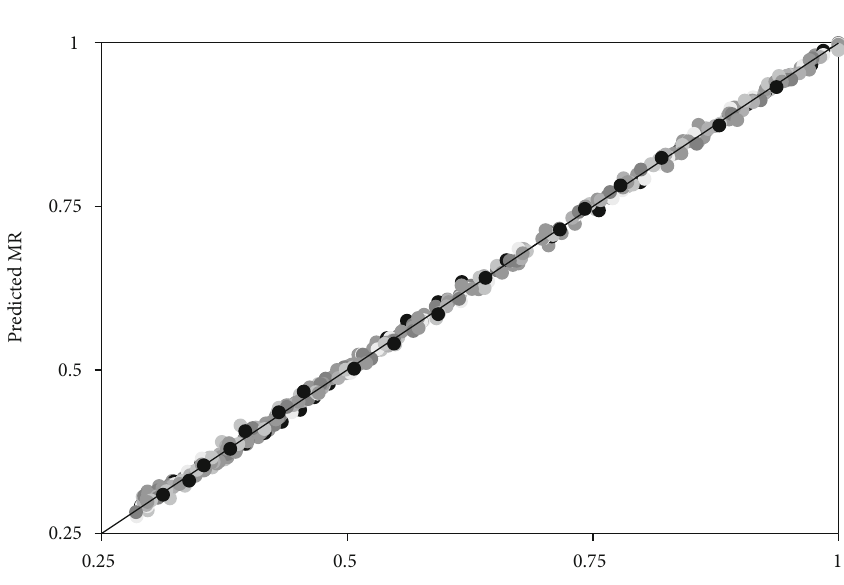
Figure 6: Comparison between the MR predicted by the two-term model and the experimental MR for all the drying